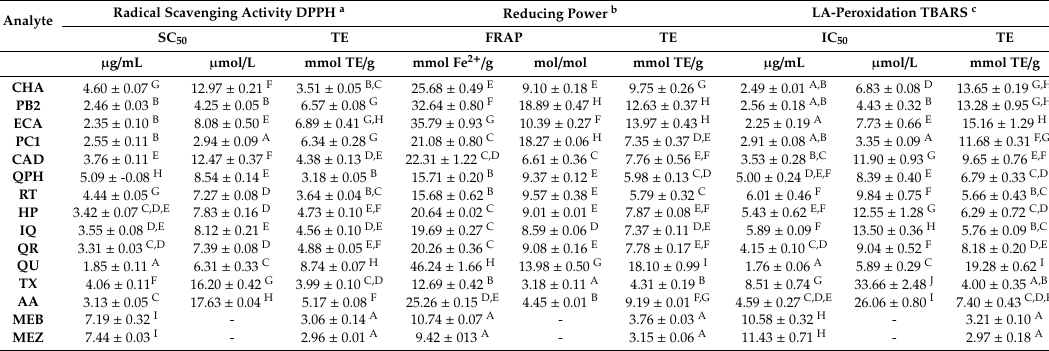
Table 3. Antioxidant activity of Cotoneaster polyphenols in chemical